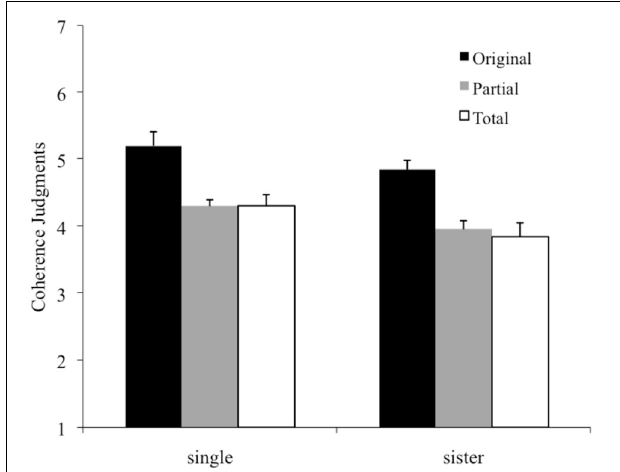
FIGURE 4 | Mean coherence ratings shown as a function of Tone Set and Timbre Material. The maximum possible rating is 7. Error bars refer to standard errors of the